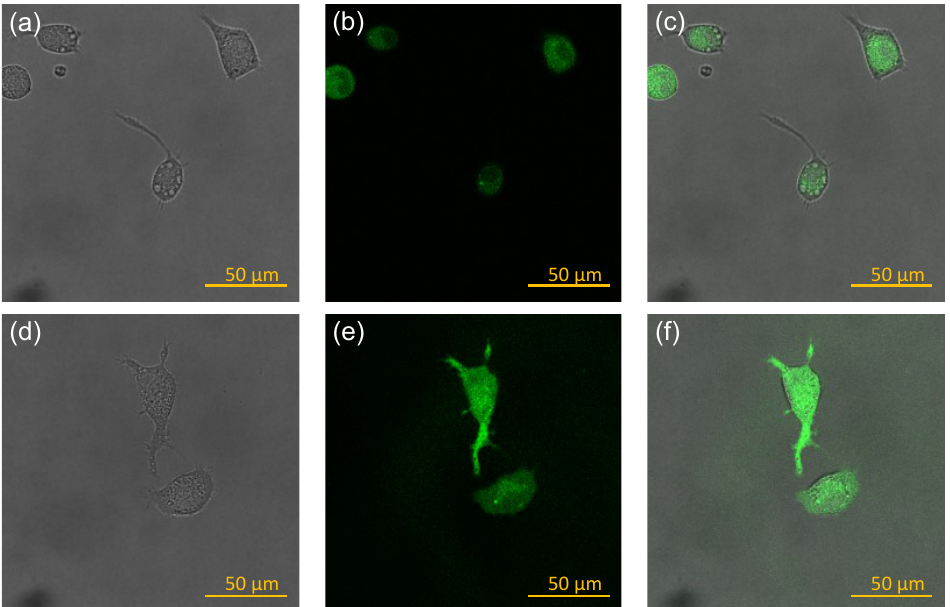
Figure 6. NO staining of macrophages at 24 h after being treated with 100 ng/mL of LPS: ( a , d ) optical microscopy images; ( b , e ): confocal microscopy images; ( c , f ): superposition of the